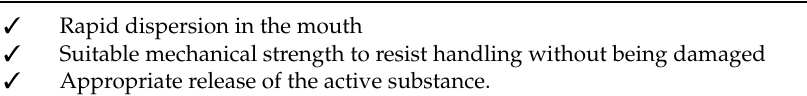
Table 5. Requirements of ODFs according to Ph.